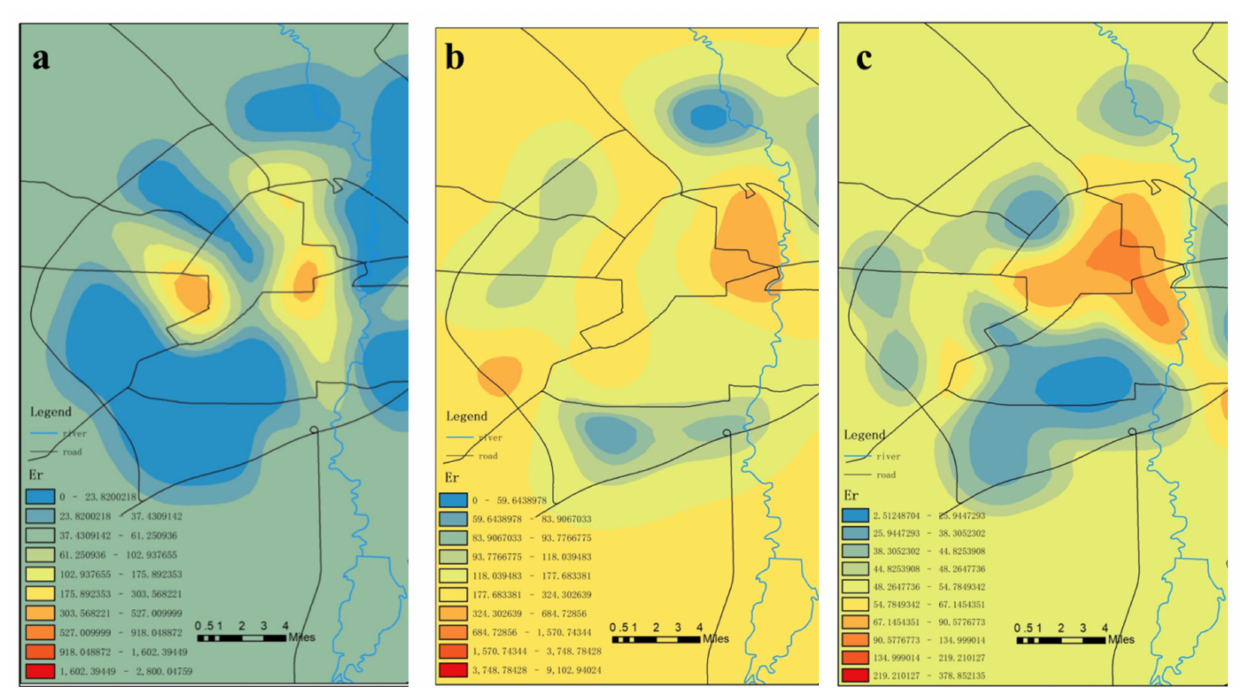
Figure 11. Potential ecological risk assessments: ( a ) distribution of the potential ecological risks of mercury pollution in the attachments; ( b ) surface soil; ( c )